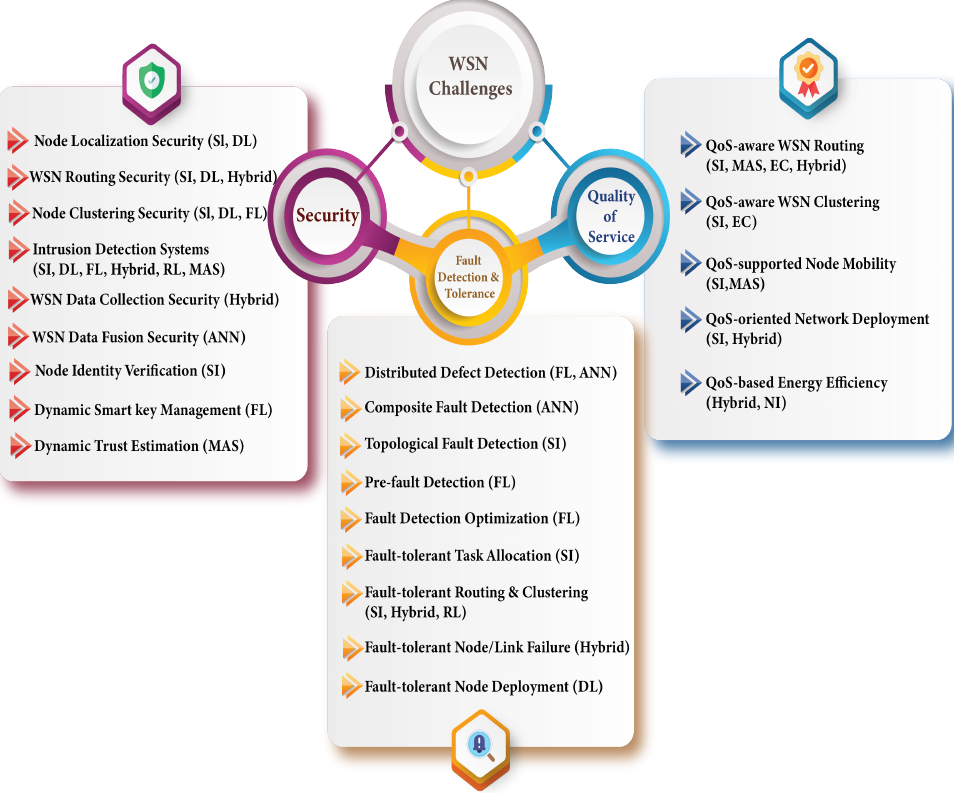
Figure 5. A summary of the main WSNs problems addressed using AI-based